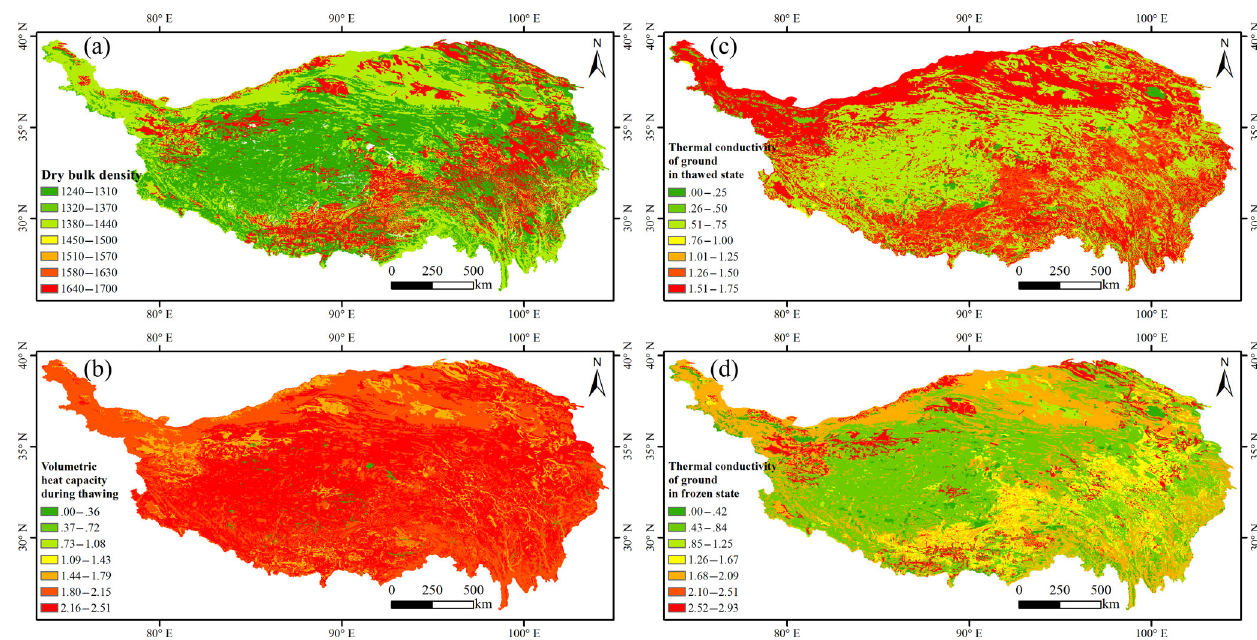
Figure 3. Spatial parameters for PIC v1.3 over the Qinghai–Tibet Plateau. (a) Dry bulk density ρ ; (b) volumetric heat capacity during thawing C T ; (c) thermal conductivity of ground in thawed state λ t ; (d) thermal conductivity of ground in frozen state λ f .